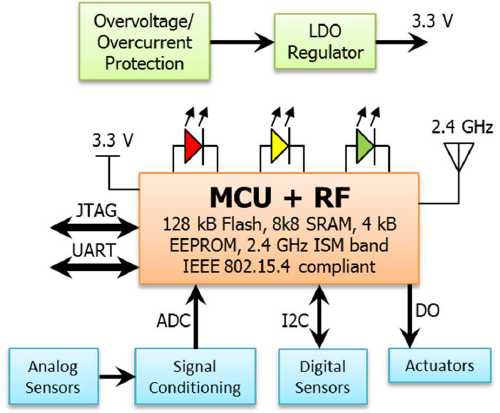
Figure 2. Block diagram of the coordinator/router nodes.